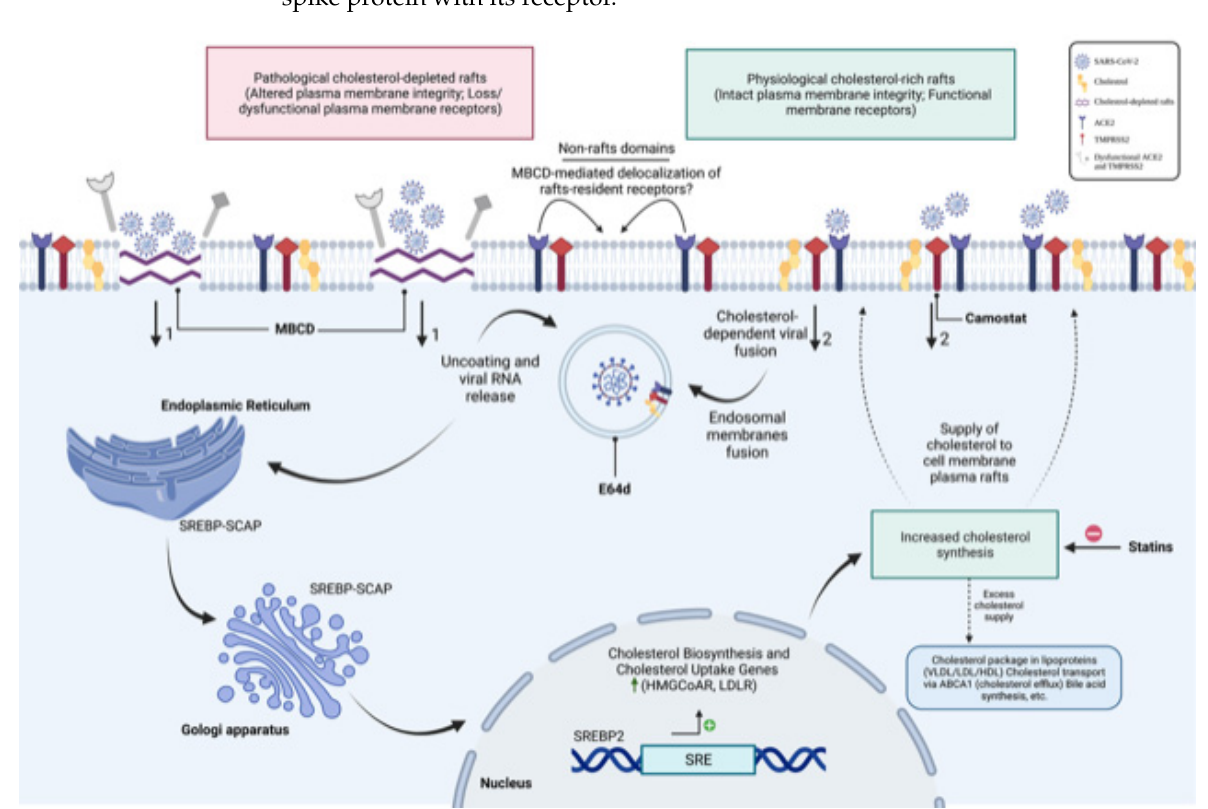
Figure 10. Hypothetical schematic representation depicting the importance of cellular cholesterol homeostasis in SARS-CoV-2 entry in host cells. Entry of SARS-CoV-2 occurs through the binding of the viral spike protein with the host ACE2 receptors facilitated by TMPRSS2 and the possible interaction with the cholesterol of raft domains. Once the viral RNA is released, the viral DNA is formed by integration with the host DNA and replication, leading to synthesis of mRNA and production of structural and non-structural proteins in the ER/Golgi compartments. Cholesterol-depleting agents such as M β CD or nystatin (relatively high doses) result in disruption of cell membrane integrity associated with membrane receptor dysregulation, leakage, or shift of ACE2 receptors to non-raft domains, leading to enhanced entry of SARS-CoV-2 particles into the cells ( arrow 1 ). The definition “pathological rafts” adopted in this schematic is not related to any of the known pathological diseases; it is used for the purpose to emphasize the degree of structural disruption of lipid rafts caused by cholesterol-rich raft-sequestering agents. In contrast, when sufficient cholesterol is available in the raft domains, SARS-CoV-2 binds to the ACE2 receptor and efficiently enters the host ( arrow 2 ) for productive infection. For simplicity, other residents of the plasma membrane such as sphingolipids are not illustrated in this diagram. Possible synergy between cholesterol and sphingolipids may influence virus entry in the host due to the high affinity of sphingolipids for cholesterol in the membrane rafts. SARS-CoV-2 may hijack cellular cholesterol to cause a reduction in cholesterol levels in the ER and consequently initiate the SREBP/SCAP complex to move from the ER to the Golgi where two proteases cleave SREBP. After cleavage, the NH2-terminal region of SREBP translocates to the nucleus to activate the transcription of target genes involved in cholesterol biosynthesis and transport. The large amount of newly synthesized cholesterol serves as a supply for the plasma membrane, and the excess of cholesterol is packaged into lipoproteins or effluxes by the cholesterol transporter ABCA1 or used for bile synthesis. How SARS-CoV-2 could hijack intracellular cholesterol to potentially modulate cholesterol fluxes (in/out of the host) needs to be